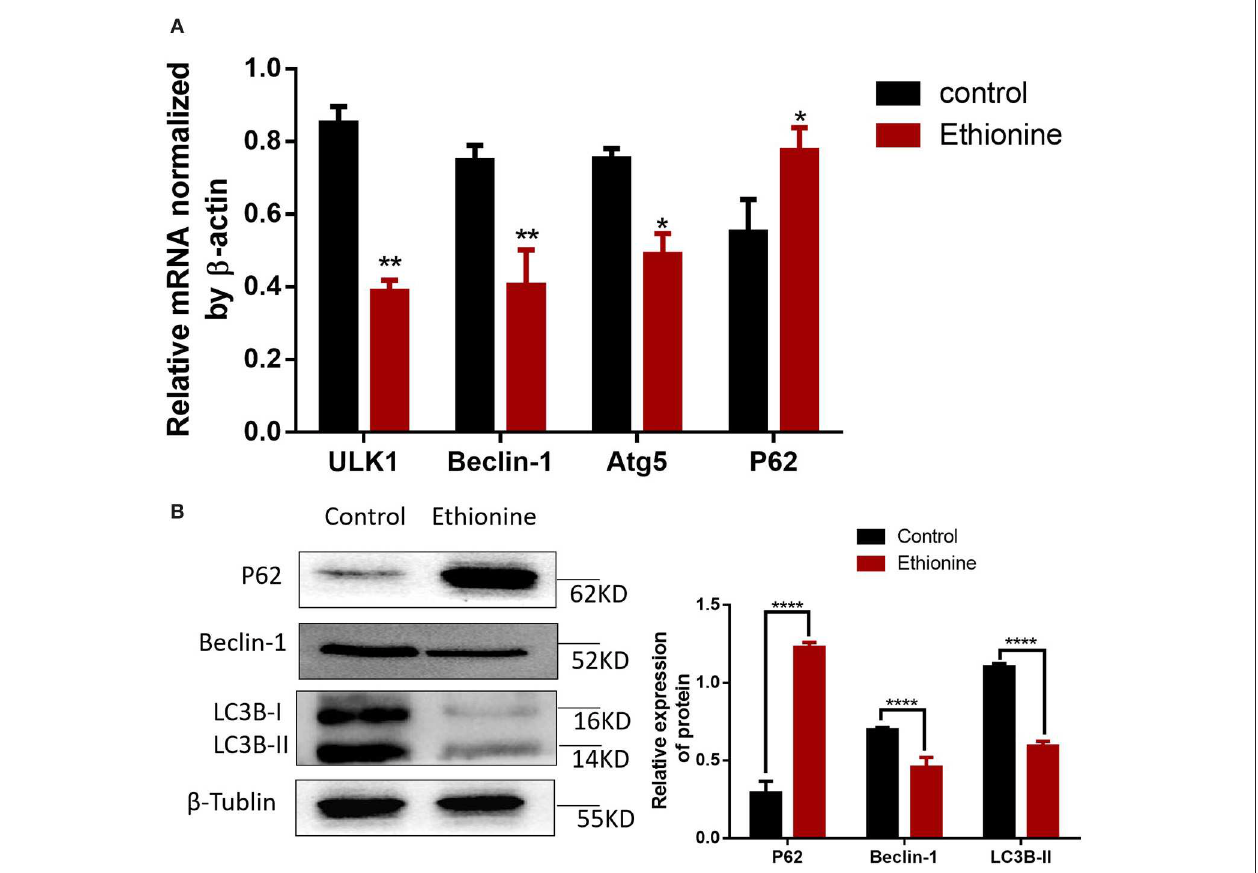
FIGURE 3 | Ethionine suppressed autophagy in normal and NTD embryos. (A) mRNA level of autophagy related genes were analyzed by qRT-PCR in normal and NTD embryos. The β -actin gene was used as a control. (B) P62, Beclin-1 and LC3B protein levels in control and ethionine groups were evaluated via Western blotting. β -Tublin levels were also evaluated to confirm equal loading ( n = 5), Each experiment was carried out in triplicates * P < 0.05, ** P < 0.01, and **** P < 0.0001 vs. control